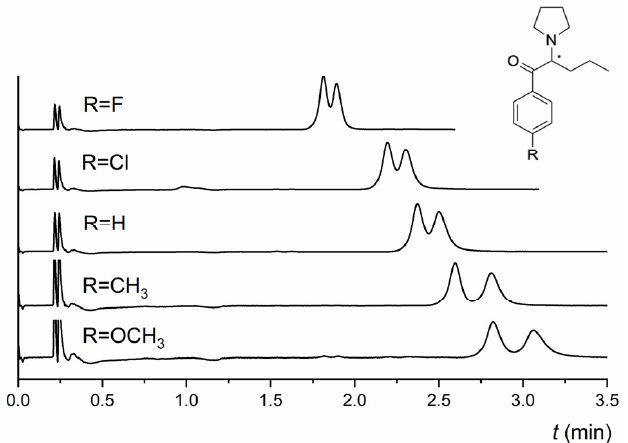
Figure 5. Influence of the analyte structure on the retention and enantioseparation of pyrovalerone derivatives on the TeicoShell column; 4-F-PVP, 4-Cl-PVP, α -PVP, 4-MPrC, and 4-MeO- α -PVP. MP composition: CO 2 /EtOH/PrOH/H 2 O/TFA/TEA (85/12/3/0.25/0.2/0.2, v / v / v / v / v / v ). SFC conditions: flow rate 1.20 mL min − 1 ; column temperature 25 ◦ C; BP 13.8 MPa; UV detection 254 nm. (*) in the structure indicates a stereogenic center.